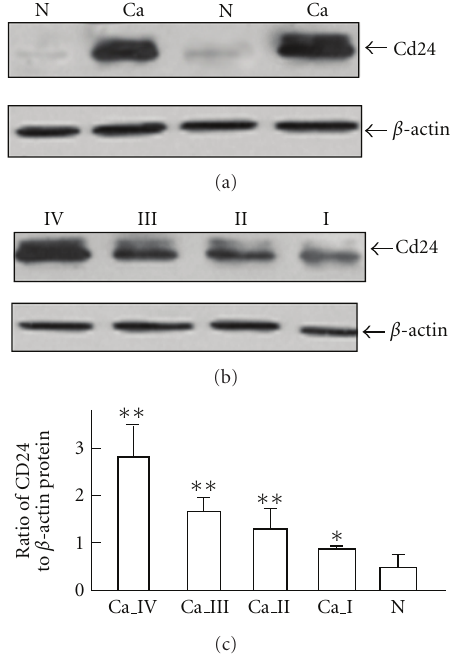
Figure 3: Expression of CD24 protein in glioma and nonneoplastic brain tissues by Western blot analysis. (a) CD24 expression levels in glioma and nonneoplastic brain tissues. (b) CD24 expression levels in glioma with di ff erent WHO grades. (c) CD24 expression levels in nonneoplastic brain tissues and glioma with di ff erent WHO grades. “N” refers to nonneoplastic brain tissues; “Ca” refers to glioma tissues; “Ca I” ∼ “Ca IV” refer to glioma tissues with WHO grade I ∼ IV. β -actin was used as a control for equal protein loading. Values are means ± SD. “ ∗ ”, P < 0 . 05, comparison with nonneoplastic brain tissues; “ ∗∗ ”, P < 0 . 01, comparison with nonneoplastic brain